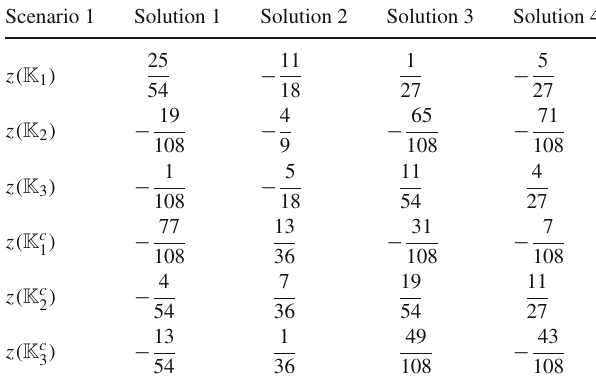
Table17 Valuesofthe U ( 1 ) (cid:2) chargesfortheexoticquarksinU μν SSM models using solution (29) with the hypercharges of Table 4. For each column, the U ( 1 ) (cid:2) charges of the rest of the fields are given in Table 2 and Scenario 1 of Table 3 of Sect. 4. The number of singlets under the SM gauge group consistent with these charges is n ν c = 2 , n S = 2 and n N = 1